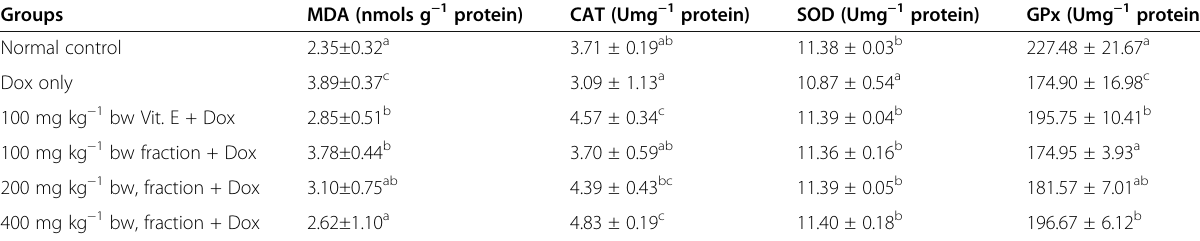
Results are expressed as mean ± SD. n =5. Values in the same column having different superscripts differ significantly ( p <0.05) MDA malondialdehyde, CAT catalase, SOD superoxide dismutase, GPx glutathione peroxidase